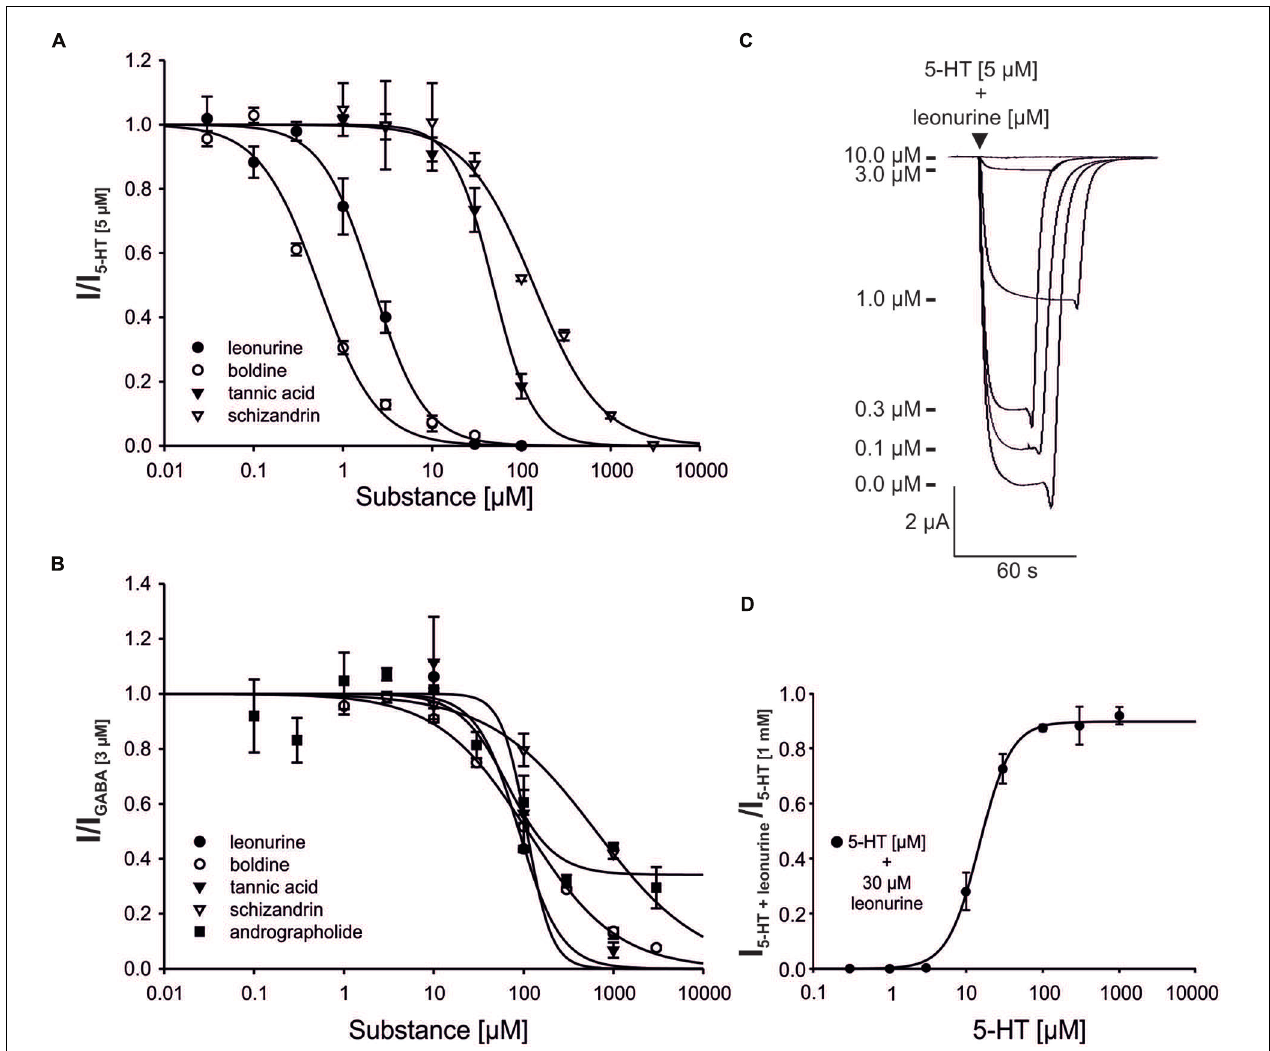
FIGURE 5 | Concentration-inhibition curves of select plant ingredients for the 5-HT 3A (A) and GABA A (B) receptor, as well as the original registrations of leonurine for the 5-HT 3A receptor (C) and the 5-HT concentration-effect curve in the presence of leonurine (D). (A,B) The agonist concentrations used in the experiment were 5 µ M (5-HT) or 3 µ M (GABA). Error bars represent the SEM ( A : n = 5–7, B : n = 4–7). Andrographolide acts as a partial antagonist of the GABA A receptor. (C) Overlayed 5-HT 3A receptor responses, modulated by different concentrations of leonurine (0.1–10 µ M) are shown. (D) The concentration-effect curve of 5-HT at the 5-HT 3A receptor in the presence of leonurine (30 µ M) is shown. The determined EC 50 value was found to be 14.8 µ M 5-HT ( n =